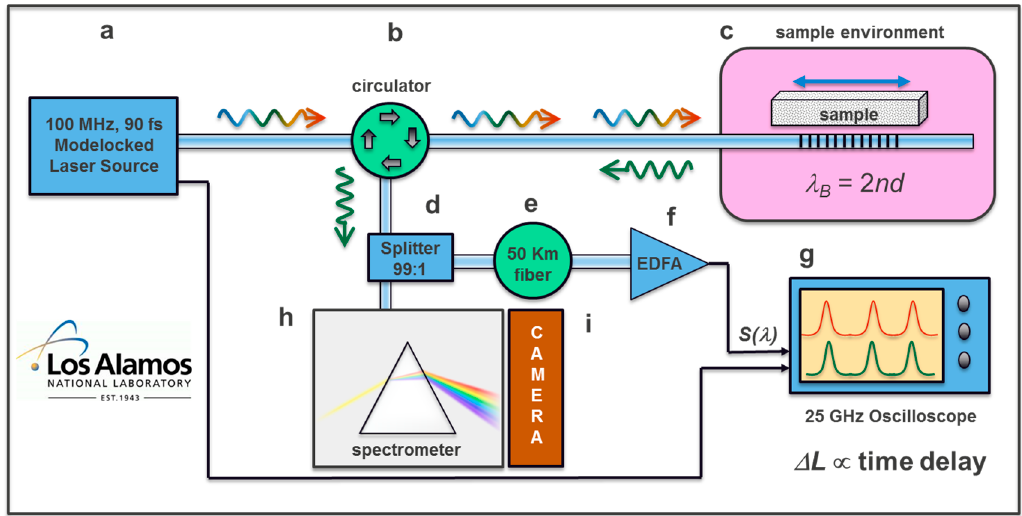
Figure 4. Coherent pulse FBG interrogation system working at 100 MHz [16,17]. ( a ) Pulsed laser light source, ( b ) circulator, ( c ) controlled sample environment in a 250 T single turn coil magnet, ( d ) 1 × 2 99:1 splitter sends 1% of the light to spectrometer, ( e ) 50–100 km spool of chromatic dispersive fiber, ( f ) Erbium-doped fiber amplifier, ( g ) ultrafast 25 GHz oscilloscope, ( h ) line array camera used for monitoring of the FBG reflection. λ B is the Bragg wavelength, n is the fiber’s index of diffraction, and d is the grating spacing.